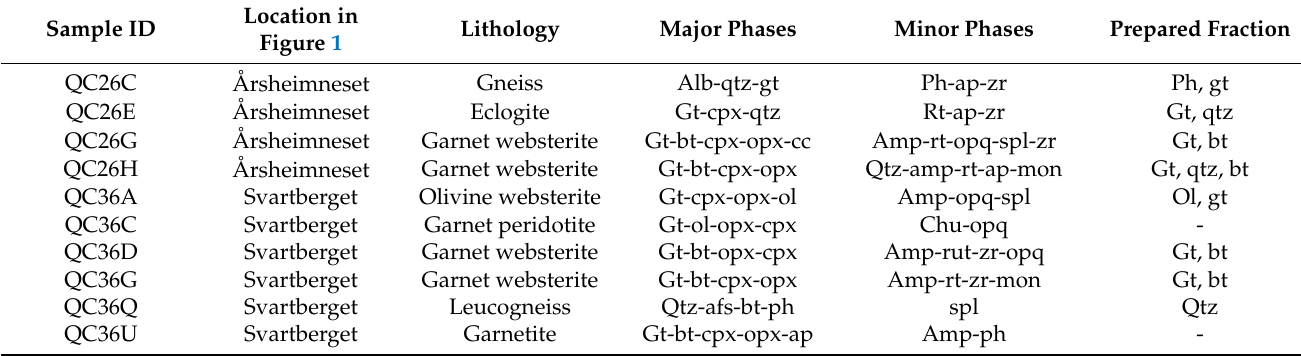
Table 1. Summary of sample collection location, protolith lithology, major and minor mineralogy and prepared mineral fraction(s) separated from WGR samples. (alb = albite; amp = amphibole; bt = biotite; cc = calcite; chu = clinohumite; cpx = clinopyroxene; gt = garnet; mon = monazite; ol = olivine; opx = orthopyroxene; opq = opaques; phe =